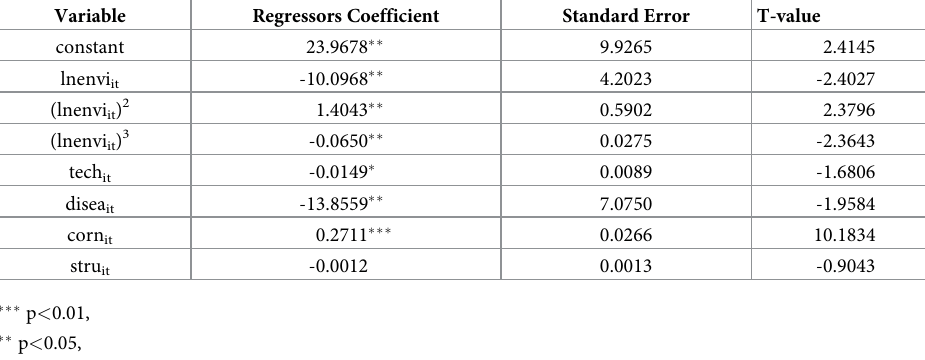
Table 10. The estimation results of influencing factors of cost inefficiency model for fattening pigs.